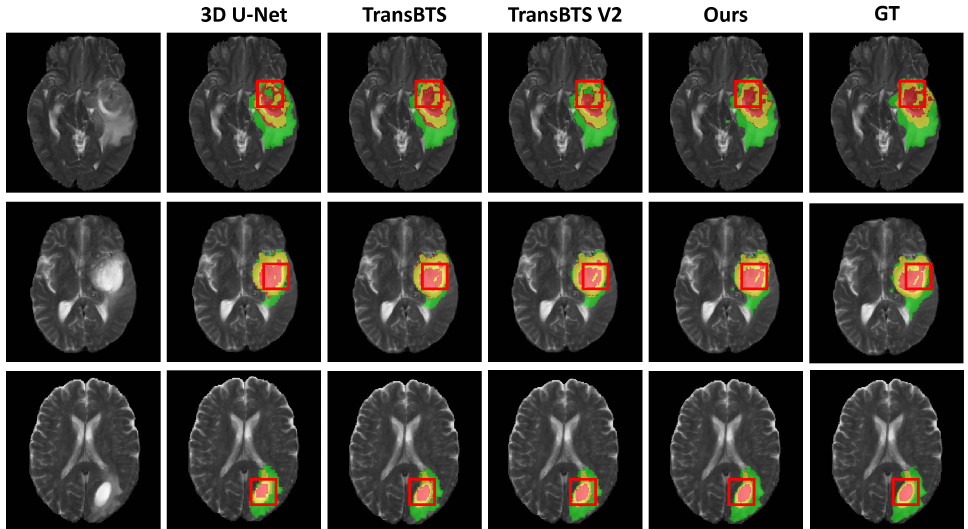
Figure 6. A Visual Comparison of MRI Brain Tumour Segmentation Results. COLUMN-1: the original image. COLUMN-2 to COLUMN-5: the results predicted by different methods. COLUMN-6: the ground truth.